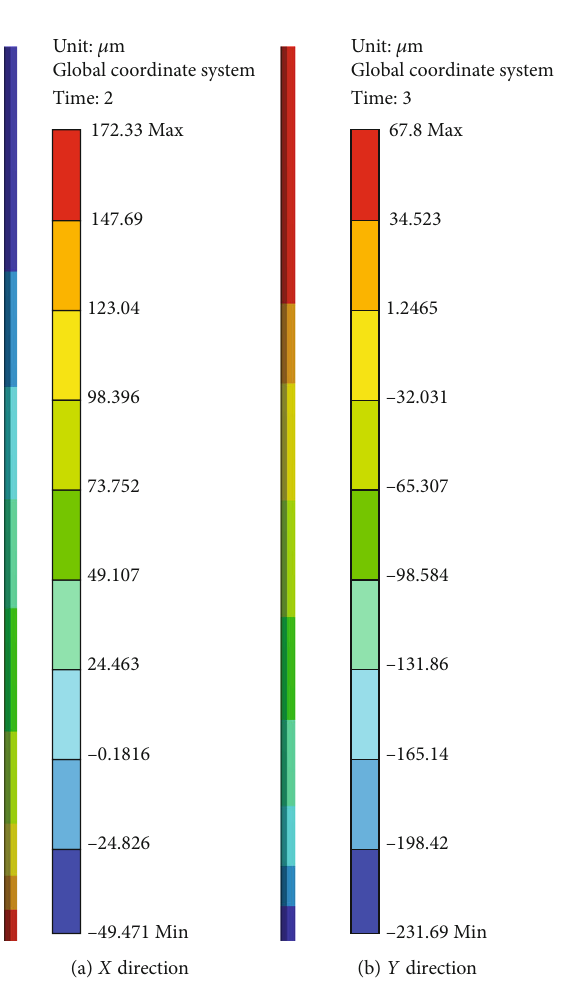
Figure 7: Displacement contours of shaft component in X and Y directions with hydraulic eccentricity of 400